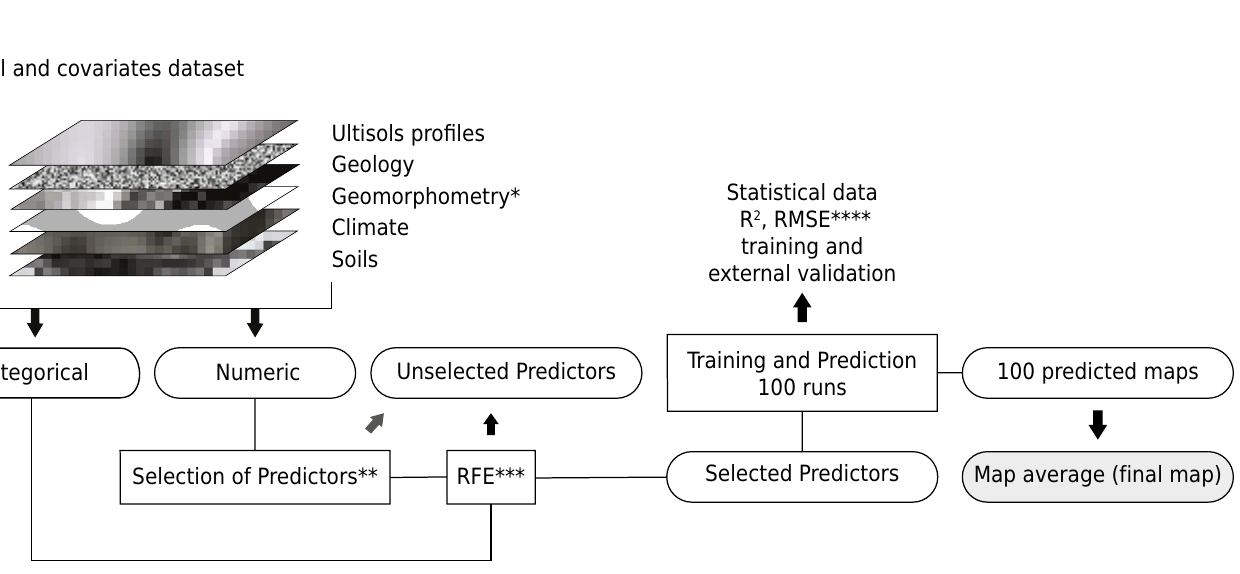
Figure 2. Flow chart representing the steps of selection of covariates and spatialization of properties of the Ultisols using the software R. Elements in the figure: * Data of the MDE-SRMT; ** findcorrelation function = refers to the data elimination that present collinearity (>97 %); *** Recursive Feature Elimination; **** Root-mean-square